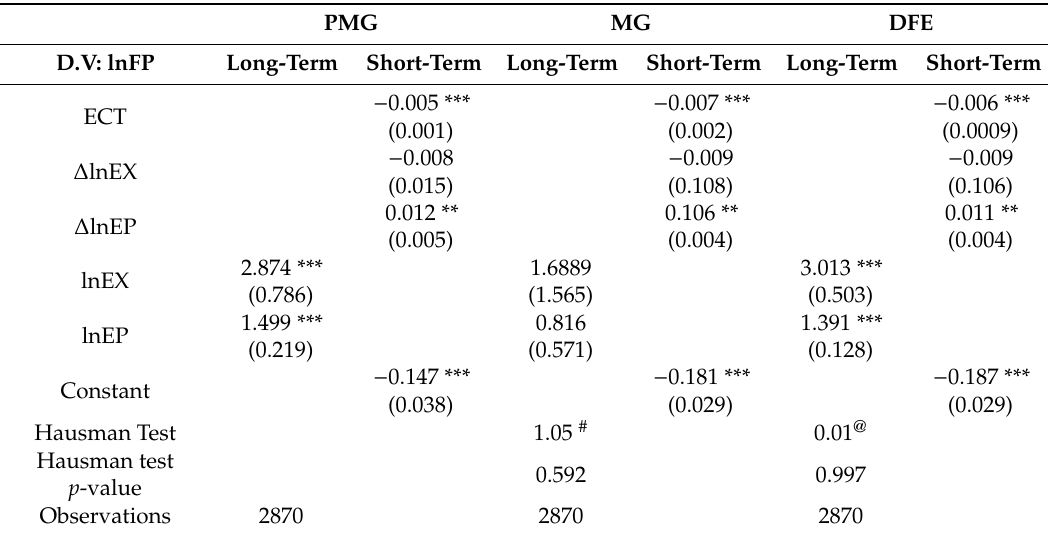
Table 4. Food prices, energy prices, and exchange rate: The dynamic